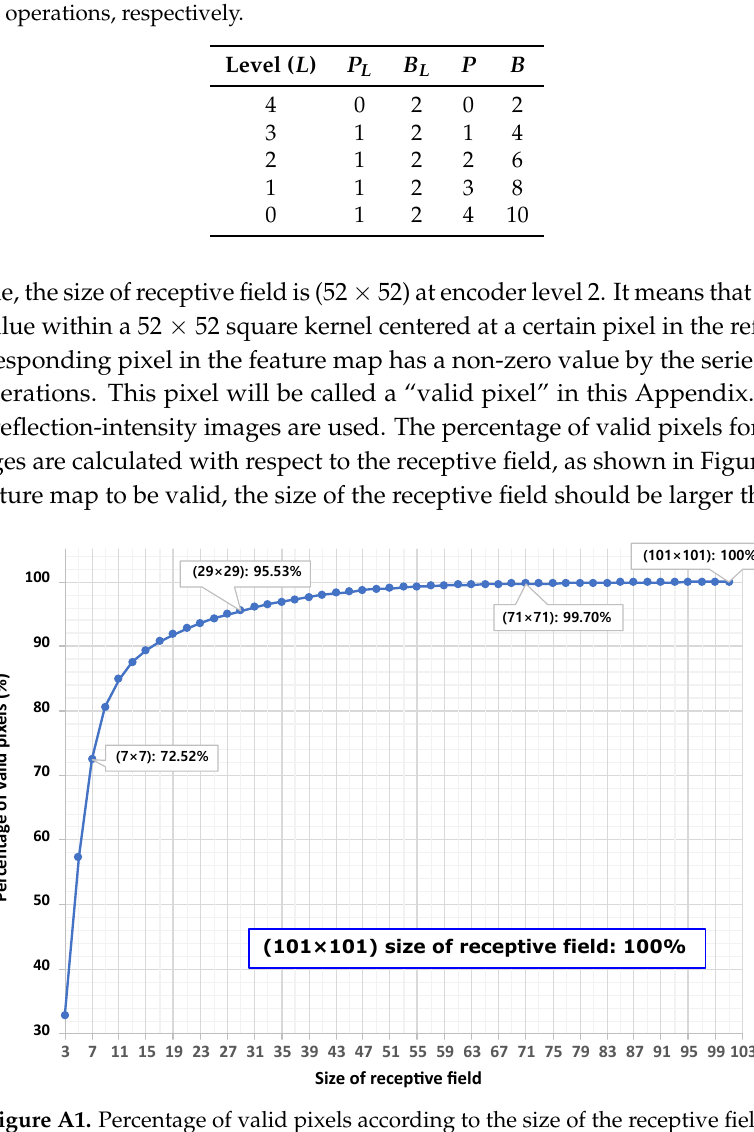
Figure A1. Percentage of valid pixels according to the size of the receptive field.